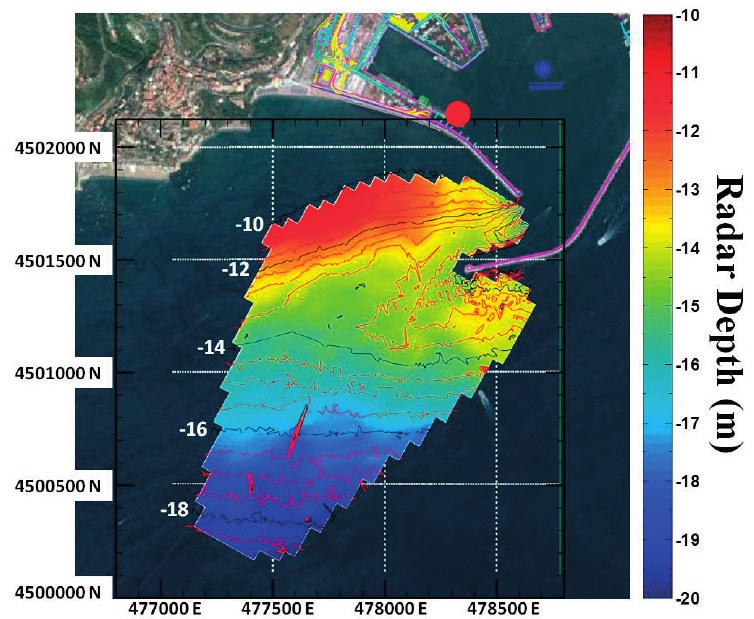
Figure 4. Reconstructed bathymetry map. The red circle denotes the radar location.